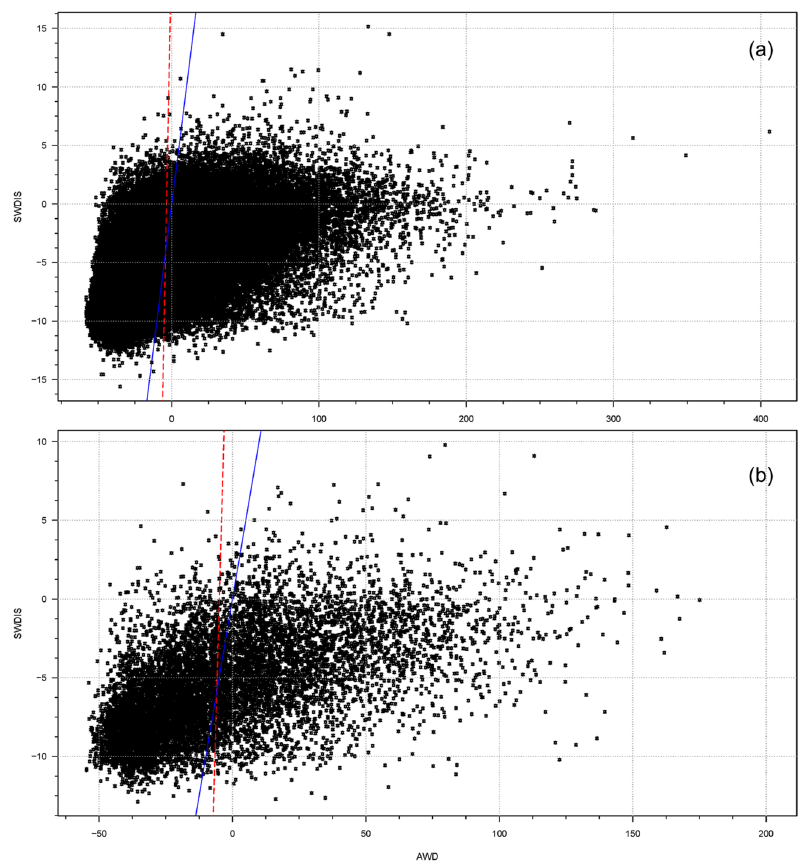
Figure 2. Observations-derived AWD and SMOS-derived SWDI from June 2010 to December 2013 considering all RDG grid cells in the NEB for: ( a ) the entire year; and ( b ) the growing season. Blue line indicates 1:1 correspondence and dashed red line gives the linear regression best fit.